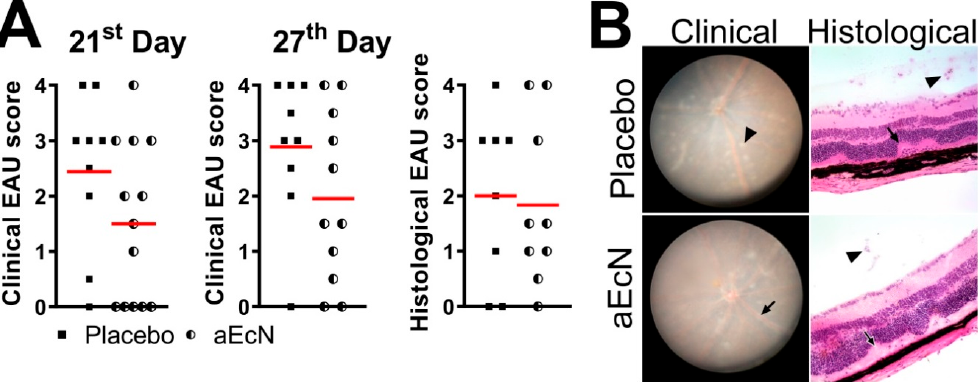
Figure 3. Treatment with autoclaved EcN from 14 days before EAU induction until day 28 post-induction is less effective than with live bacteria, graphs show individual values and red lines represent mean. ( A ) Data are pools from 2 independent experiments ( n = 9 (placebo) or 13 (aEcN) in total) and differences were quantified by unpaired Mann Whitney test. ( B ) Representative images of clinical and histological findings with typical findings marked, i.e., clinically as chorioretinal lesions (arrowhead) and vessel sheathing (arrow) and histologically as inflammatory cell infiltration of the vitreous body (vitritis, arrowheads) and retinal folds (arrows) histological (optical magnification 200 ×